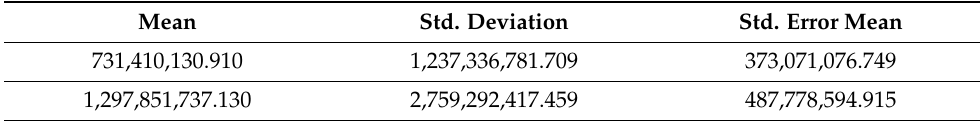
Table 7. Kruskal–Wallis test for the two groups of countries. Mean Std.